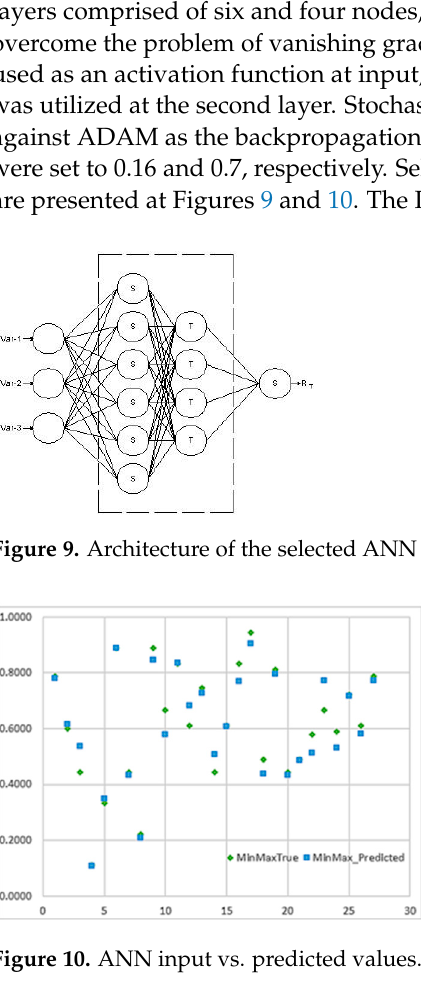
Figure 10. ANN input vs. predicted values.